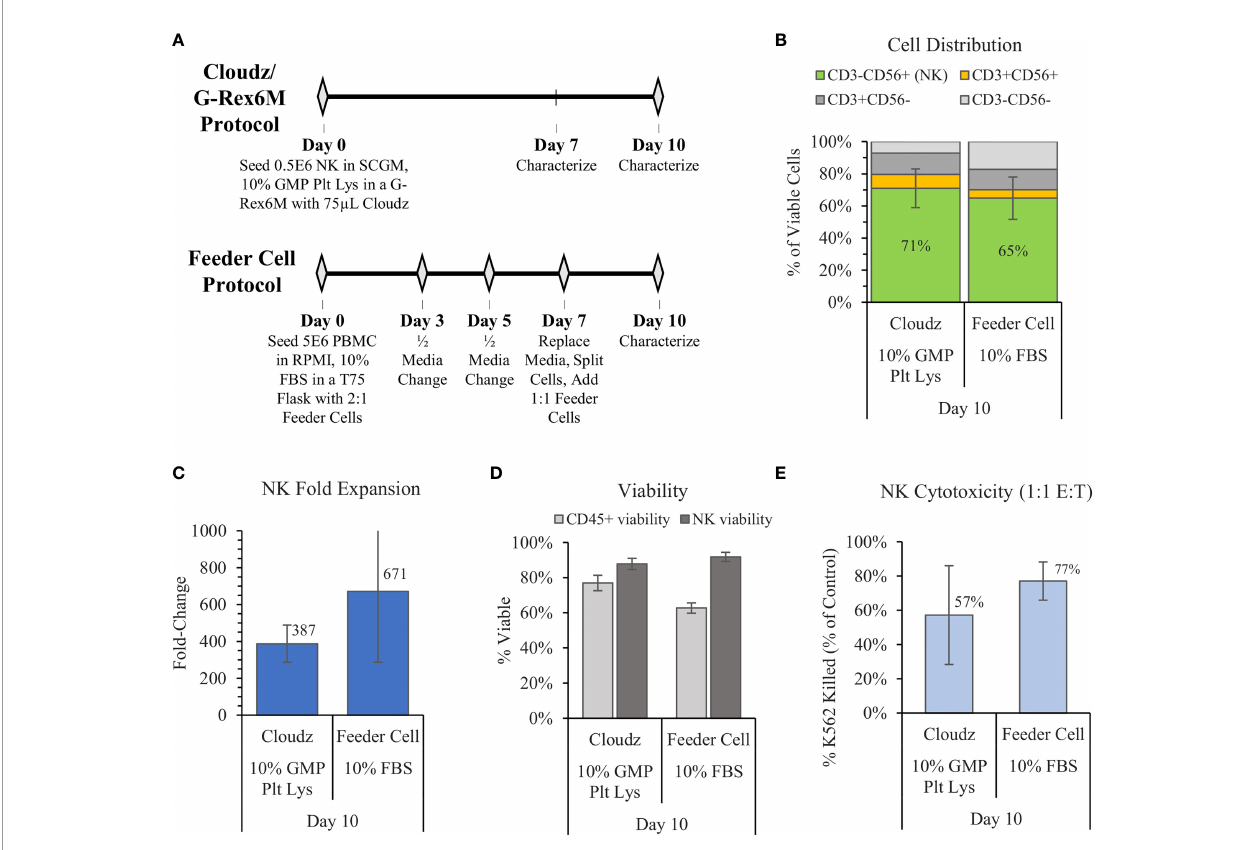
FIGURE 3 | The G-Rex6M/NK Cloudz ™ “ low-touch ” protocol compared with the fl ask-based “ high-touch ” feeder cell protocol. The feeder cell protocol used the same donors but was otherwise different: (See methods in (A) or in the Materials and Methods section). The results show the following: (B) the cell distribution on day 10, (C) the NK (CD3 − CD56 + ) fold change between days 0 and 10, (D) the viability of either all CD45 + cells (light gray bars) or NK cells alone (dark gray bars) on day 10, and (E) the percent of target K562 cells killed with a 1:1 effector:target (E:T) ratio over 4 h. Data represent the mean ± SD from 3 separate